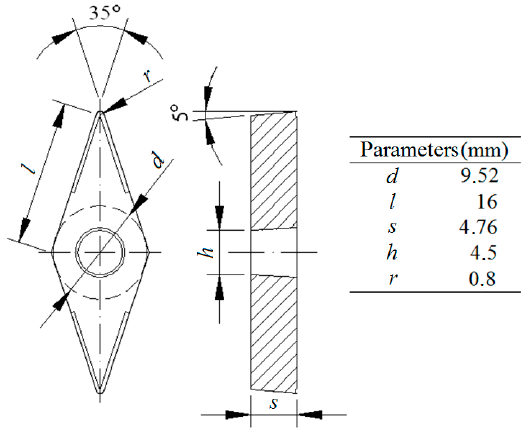
Figure 3. Turning tool geometry and dimensions.